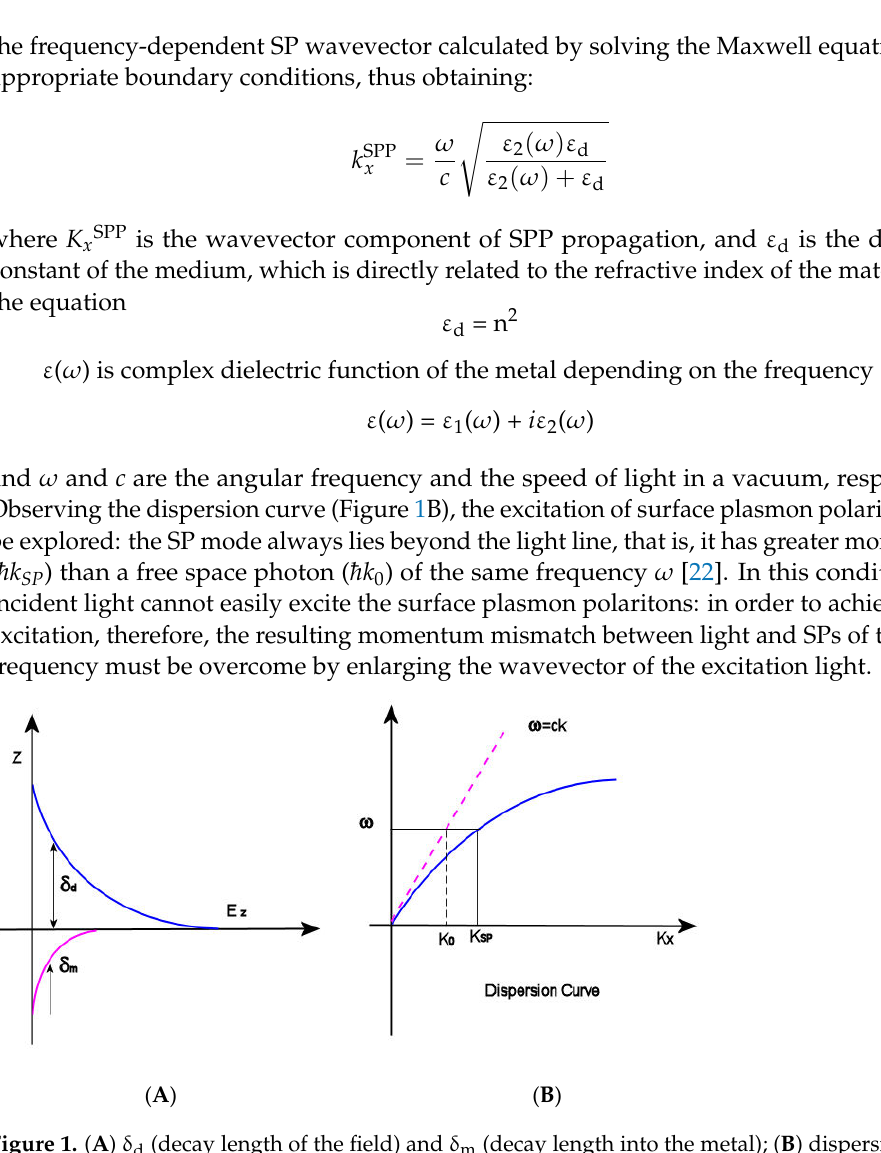
Figure 1. ( A ) δ d (decay length of the field) and δ m (decay length into the metal); ( B ) dispersion curve for an SP mode showing the momentum mismatch issue. for an SP mode showing the momentum mismatch